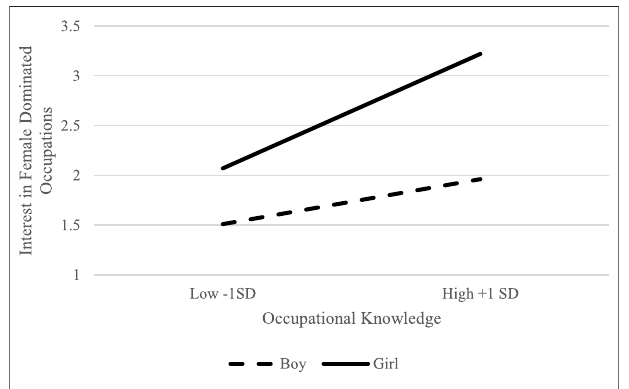
FIGURE 2 | Gender x perceived occupational knowledge